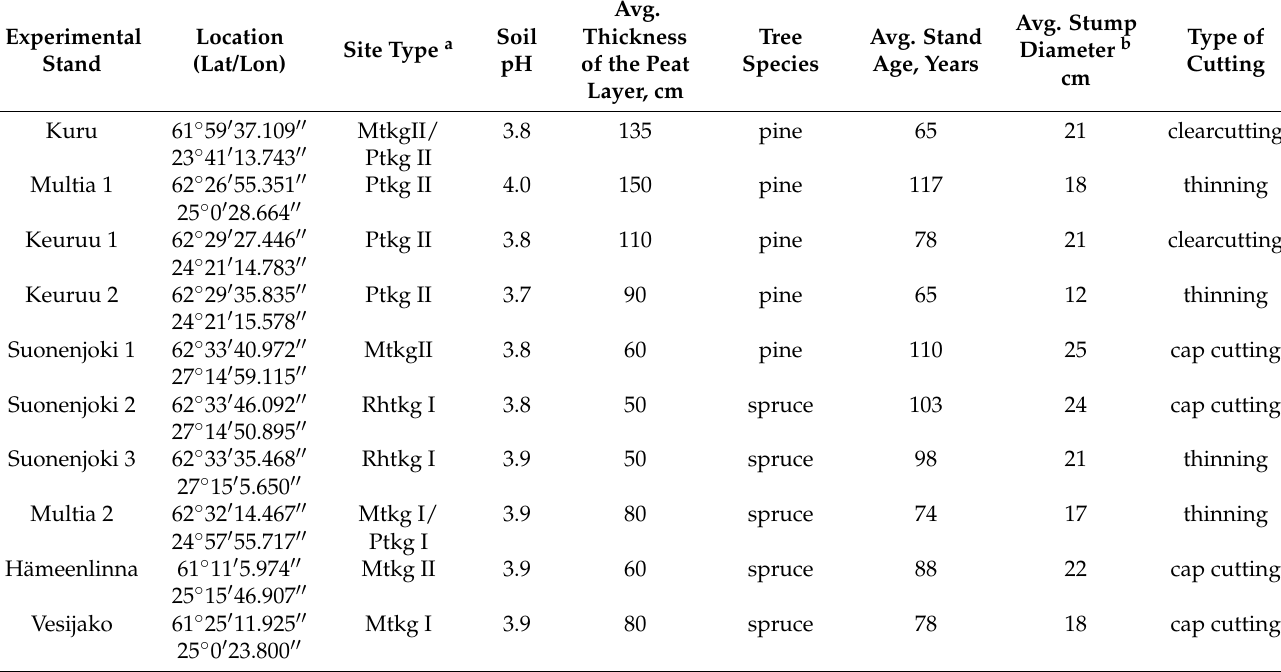
Table 1. Description of experimental